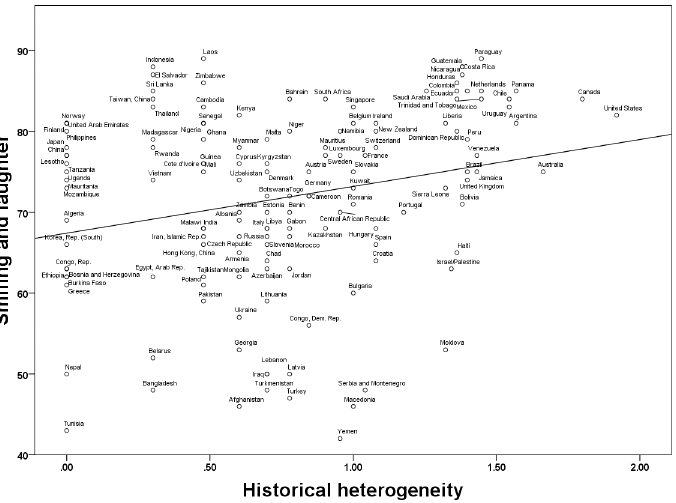
Fig 2. Smiling and laughter as a function of country-level historical heterogeneity (log-transformed units).